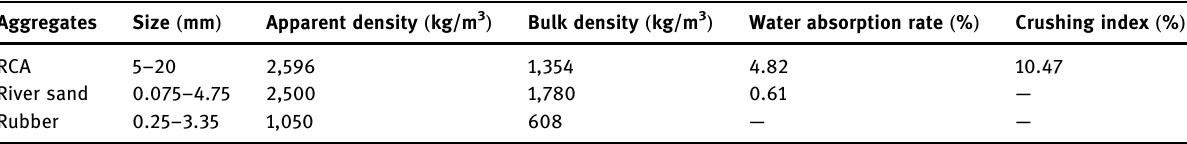
Table 2: Physical properties of aggregates